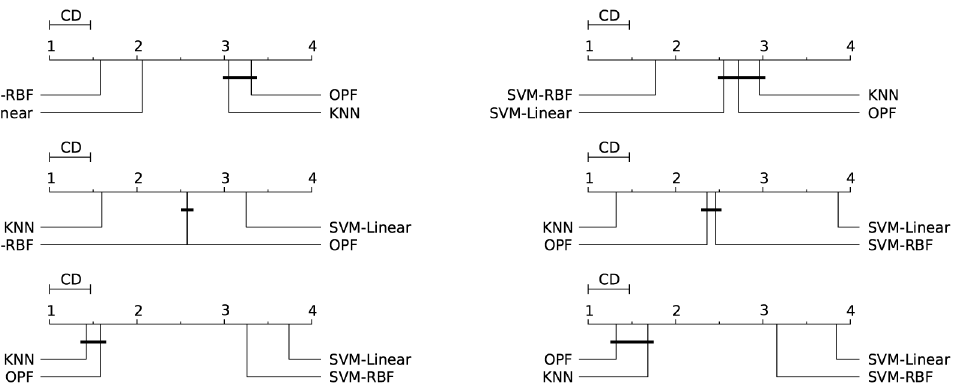
Fig 5. Covertype. Comparison of all classifiers against each other with the Nemenyi test and learning time constraint equals to 1, 5, 20, 60, 300, and 1200 seconds. Groups of classifiers that are not significantly different (at p = 0.05) are connected.